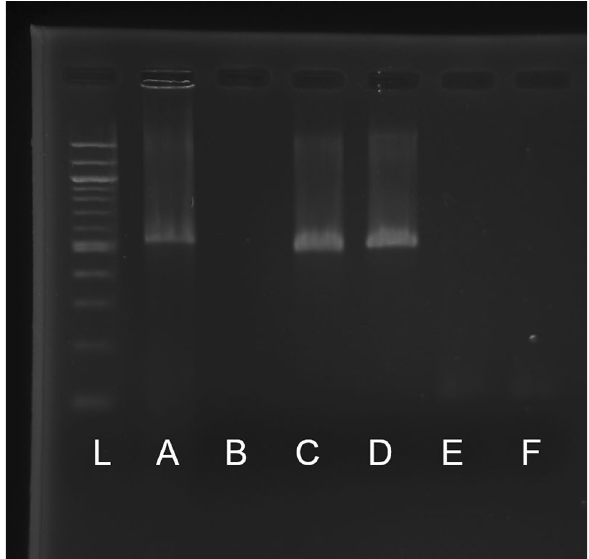
Figure 7. Molecular test of axenic condition. Gel electrophoresis (2% agarose) of 16S rRNA gene V3-V4 regions PCR amplification. ( L ) DNA marker 1000 bp (NEB) ( A ) positive control (bacterial culture, band at ~ 450 pb) ( B ) negative control (sterile water) ( C ) day 4 conventional condition (all replicate combined, band at ~ 450 pb) ( D ) day 4 axenic condition (all replicate combined) ( E ) day 20 axenic condition (all replicate combined) ( F ) negative control (ultrapure